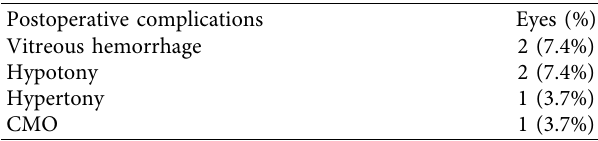
Table 3: Postoperative